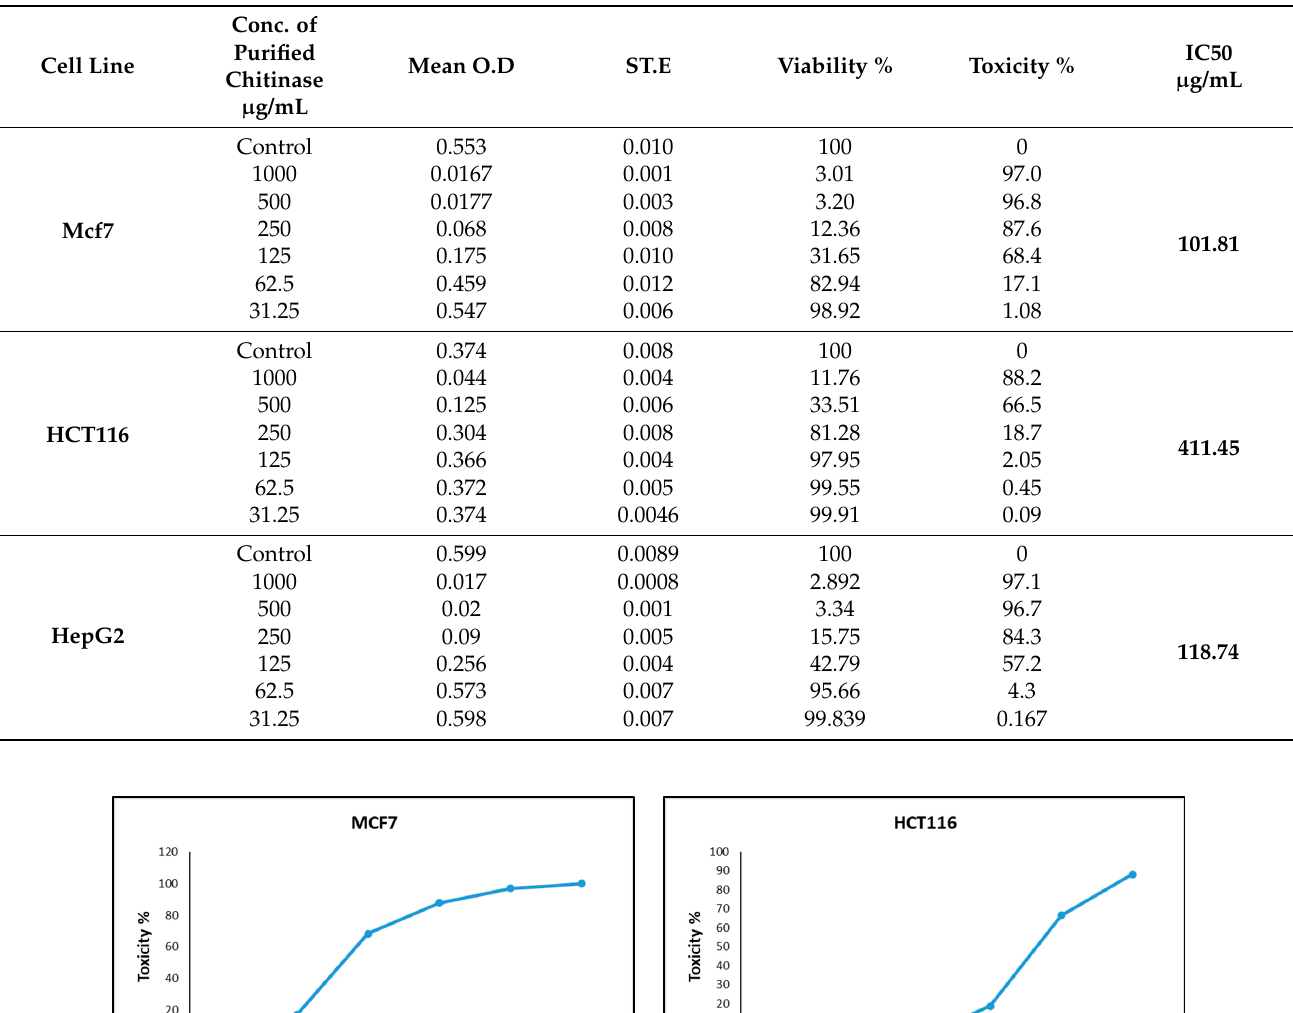
Table 6. Effect of purified chitinase by T. funiculosus strain CBS 129594 on MCF7, HCT116, and HepG2 cells.